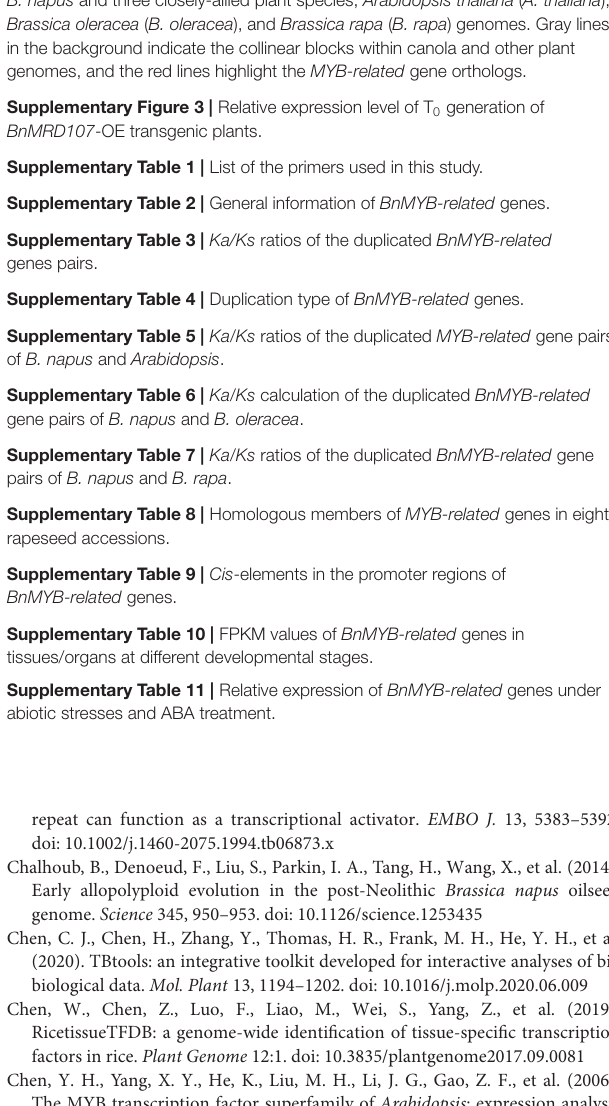
indicated at the top of each chromosome. The scale of the chromosomes was in megabases (Mb). Supplementary Figure 2 | Syntenic relationships of MYB-related genes between B. napus and three closely-allied plant species, Arabidopsis thaliana ( A. thaliana ), Brassica oleracea ( B. oleracea ), and Brassica rapa ( B. rapa ) genomes. Gray lines in the background indicate the collinear blocks within canola and other plant genomes, and the red lines highlight the MYB-related gene orthologs.